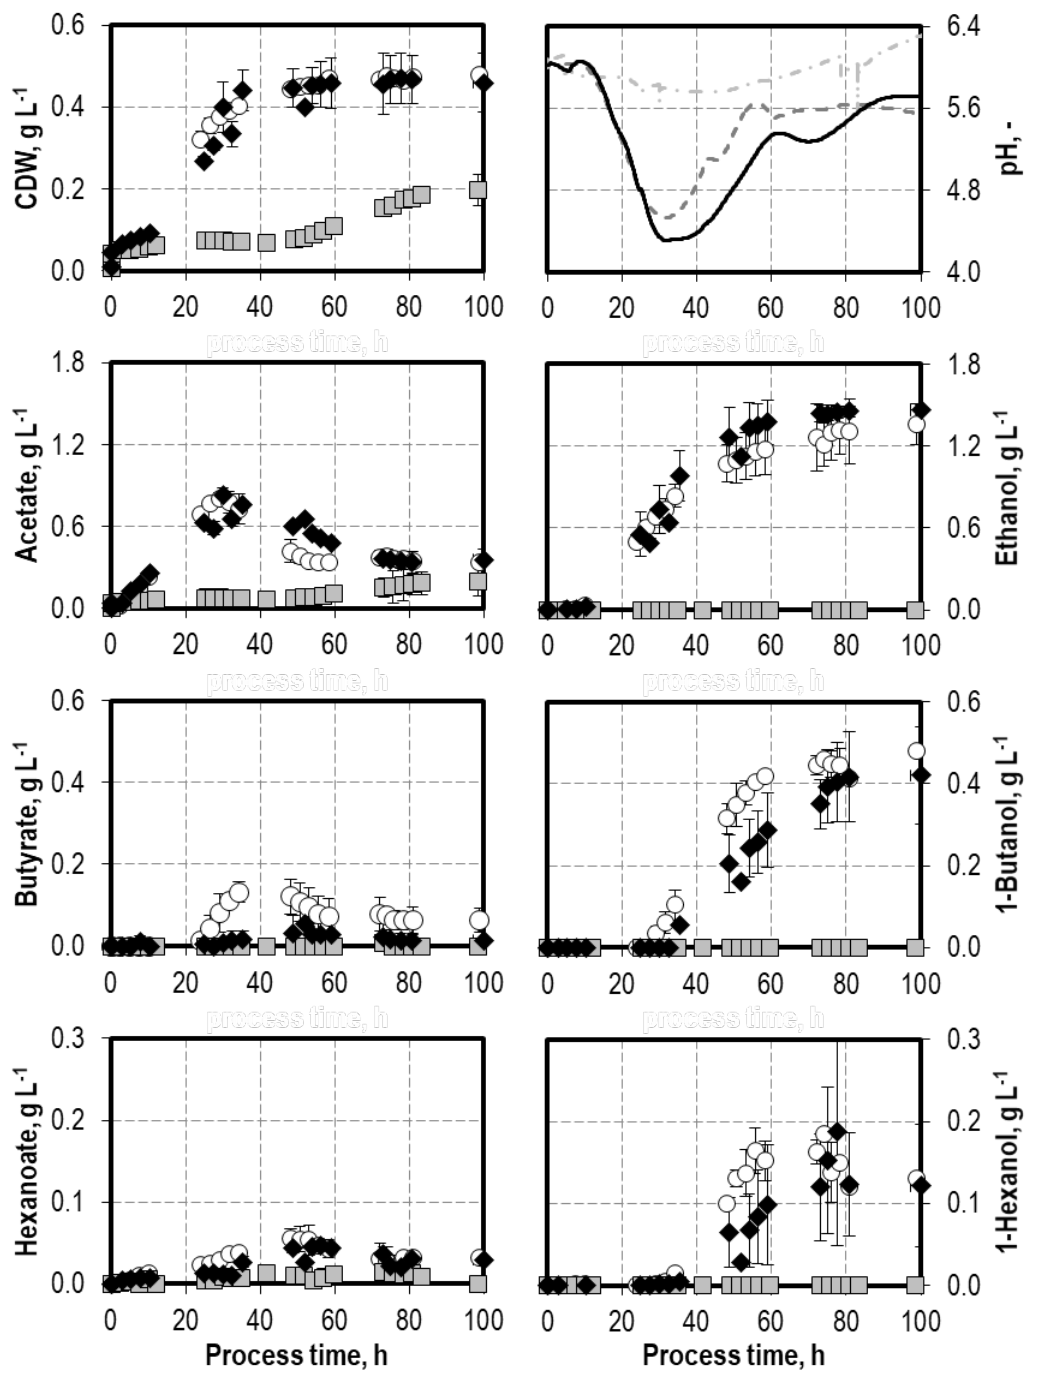
Figure 2. Autotrophic reference batch processes with C. carboxidivorans with artificial syngas (white circle, dark grey dashed line), batch processes with real syngas from entrained flow gasification of biogenic residues (torrefied wood, TorrCoal) (light grey square, light grey dash-dot line), and batch processes with biogenic syngas with oxygen reduction by a Pd catalyst (Actisorb O3) (black diamond, black solid line). Reaction conditions were constant at T = 37 °C, P V − 1 = 15.1 W L −1 , F gas = 5 NL h − 1 , pH initial = 6.0 (uncontrolled unless > pH 6.4); p CO = 300 mbar, p H2 = 220 mbar, p CO2 = 90 mbar, p N2 = 390 mbar. Error bars indicate standard deviations of three individual reference batch processes with artificial syngas, and the respective minimum and maximum values of two individual batch processes with the biogenic syngases. pH values depict the curve of one representative batch process.